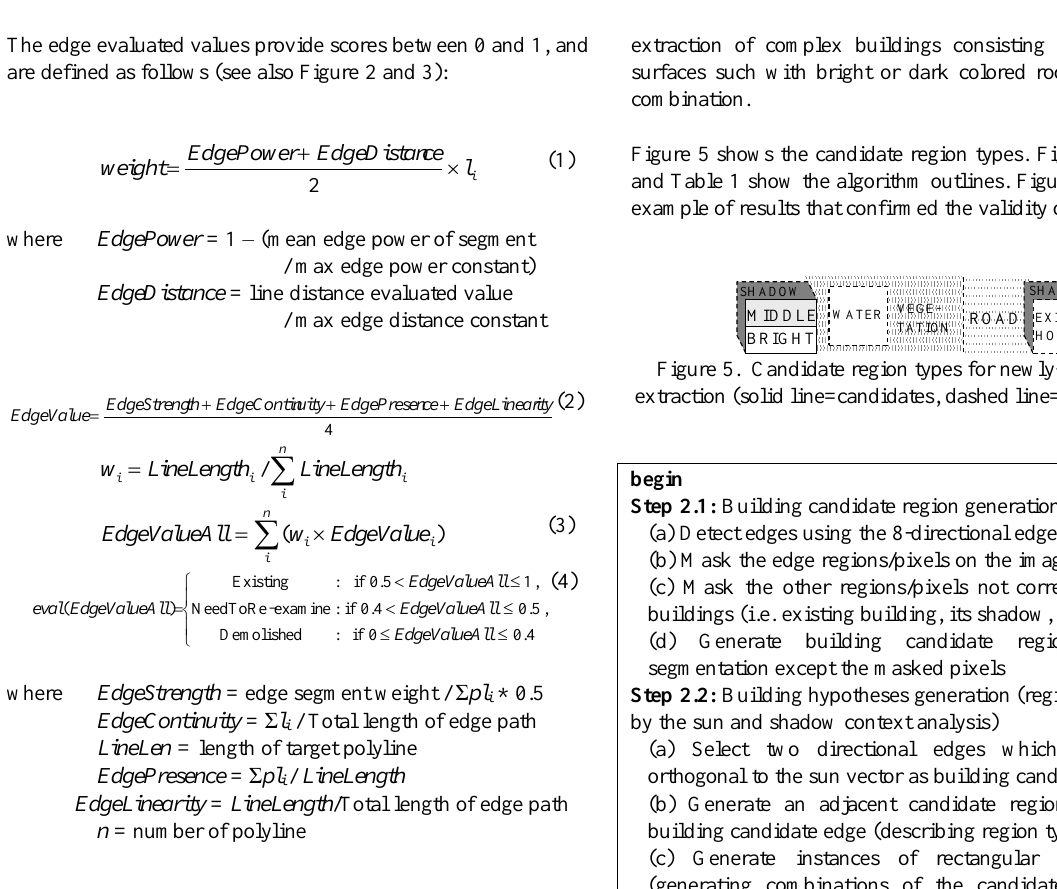
Figure 4. Example of optimal building boundary extraction result. (a)(b)(c)(d)Extracted edges. (e)Extracted building boundary. (green=light-dark direction edge, red=dark-light direction edge, color brightness=edge strength)